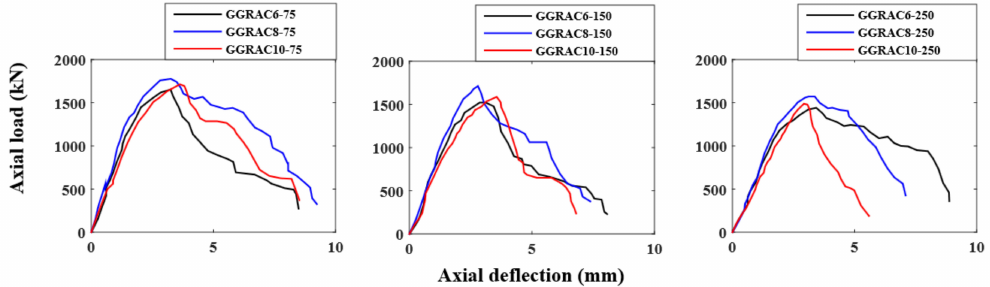
Figure 7. Influence of reinforcement ratio on the load–deflection response of GGRAC compressive